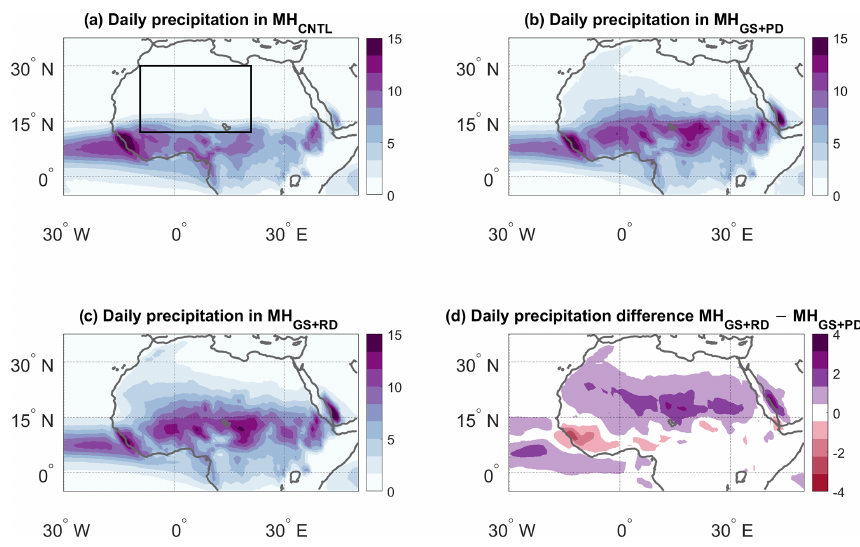
Figure 2. JJAS precipitation (mmd − 1 ) for the (a) MH CNTL , (b) MH GS+PD and (c) MH GS+RD simulations. (d) Precipitation difference between the MH GS+RD and MH GS+PD simulations. The black box in panel (a) marks the domain used to perform the dynamical systems analysis (12.5–30 ◦ N, 10 ◦ W–20 ◦ E).